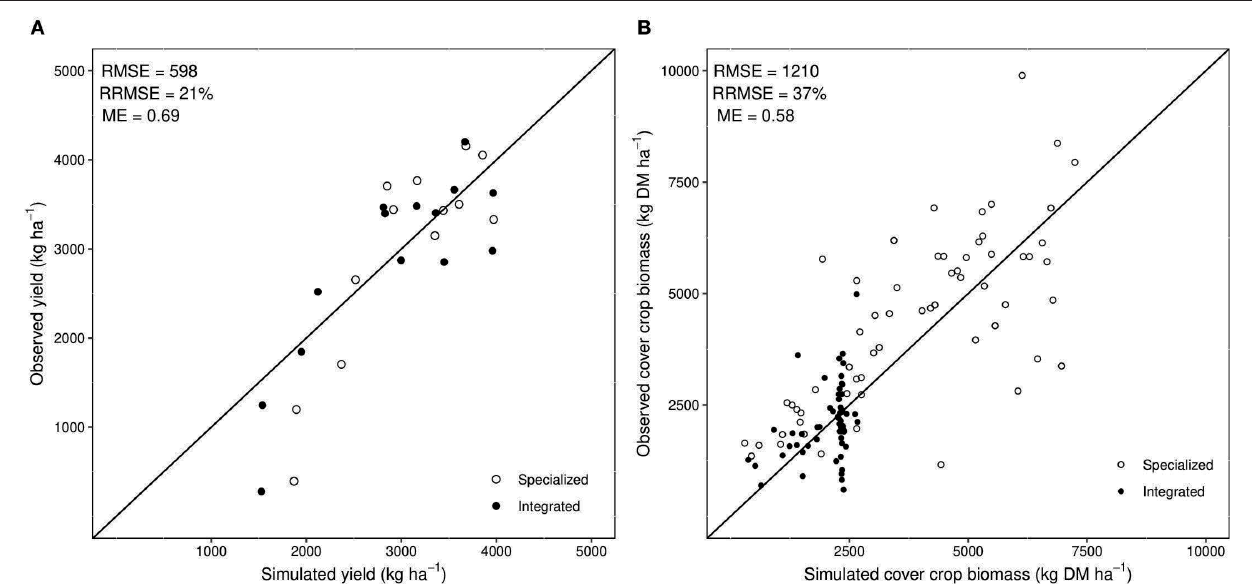
FIGURE 1 | Relationship between observed and simulated (A) soybean yield and (B) cover crop aboveground biomass production for the calibration period in the integrated system (grazed cover crop; solid points) and the specialized control (ungrazed cover crop; open points). Model evaluation indices are root mean square error (RMSE), relative root mean square error (RRMSE), and modeling efficiency (ME).